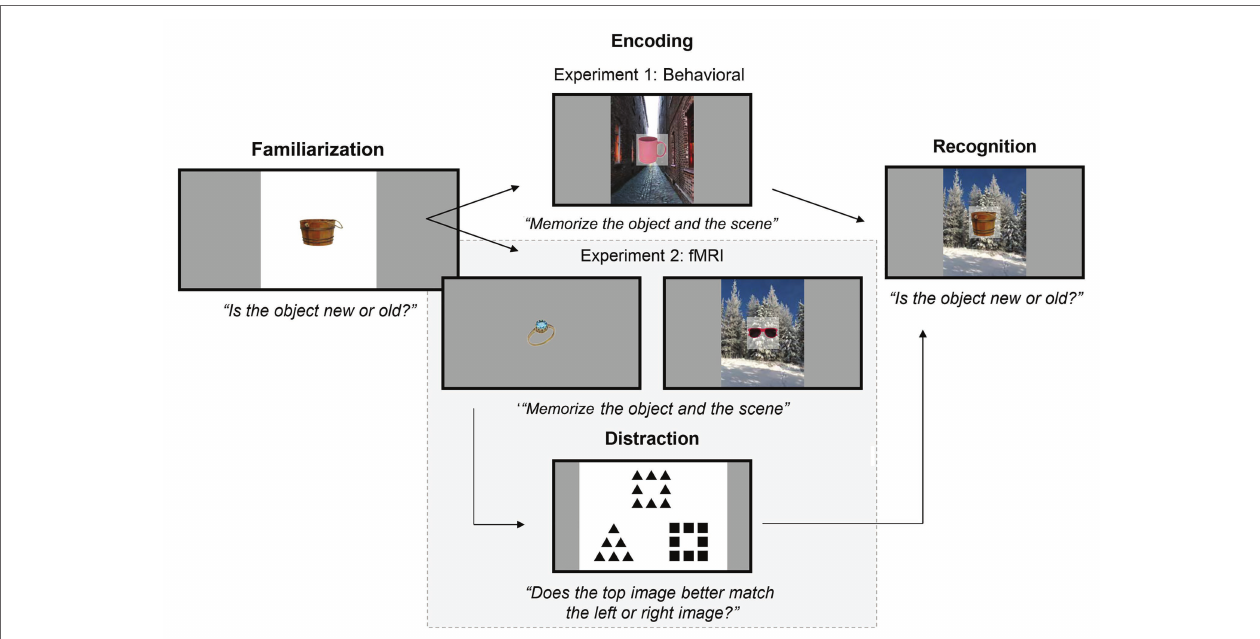
FIGURE 1 | Experimental paradigm for Familiarization on Day 1 and Encoding and Recognition on Day 2, for both experiments. On Day 1, participants were familiarized with exemplars from 10 object categories. On Day 2, participants memorized object-scene pairs (Experiments 1 and 2) and objects alone (Experiment 2). Afterwards, participants were tested on how well they could recognize old objects (i.e., objects shown during Encoding) from new objects. The background scenes during recognition were either matched to the same object as in Encoding (“intact”), swapped with a different object’s background (“rearranged”), or were with a new object entirely (“new object with old scene”). Half of the objects in Encoding and Recognition were familiarized (i.e., shown in the Familiarization stage) or non- familiarized. Note that, in Experiment 2 (highlighted by the gray box), there was an additional distraction task in between Encoding and Recognition, where participants subjectively matched images that shared either global or local geometric